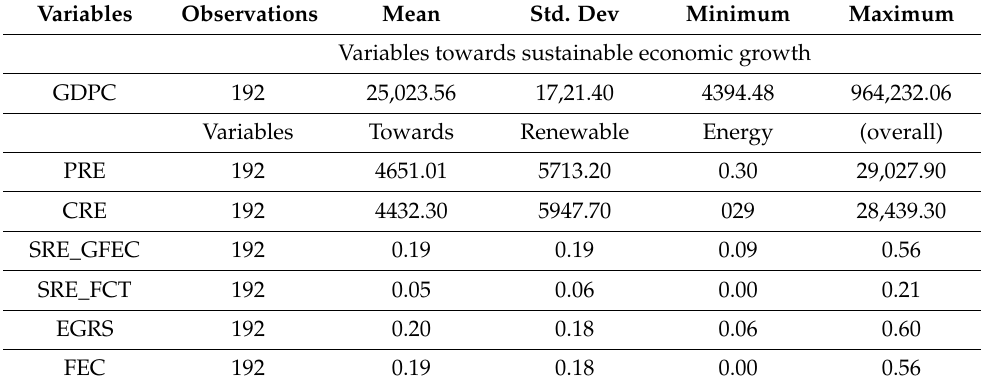
Table 1. Energy and Sustainable Economic Growth.